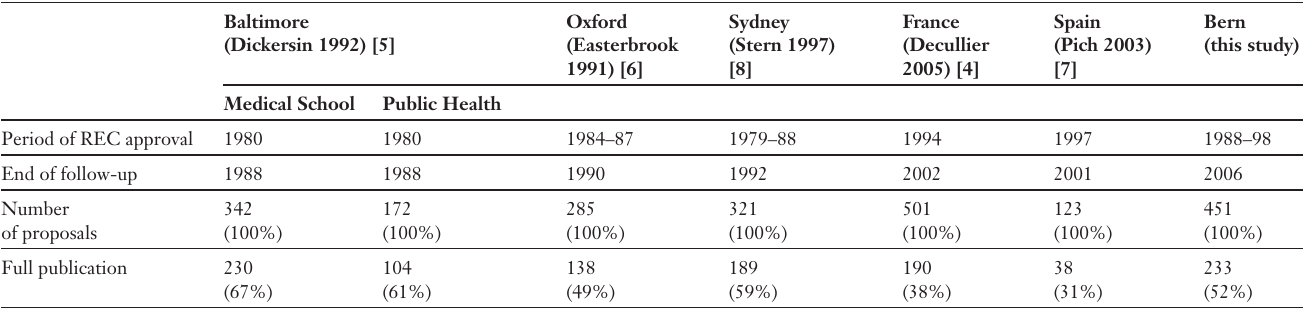
Table 3 Overview of previous studies of the publication of research proposals submitted to research ethics